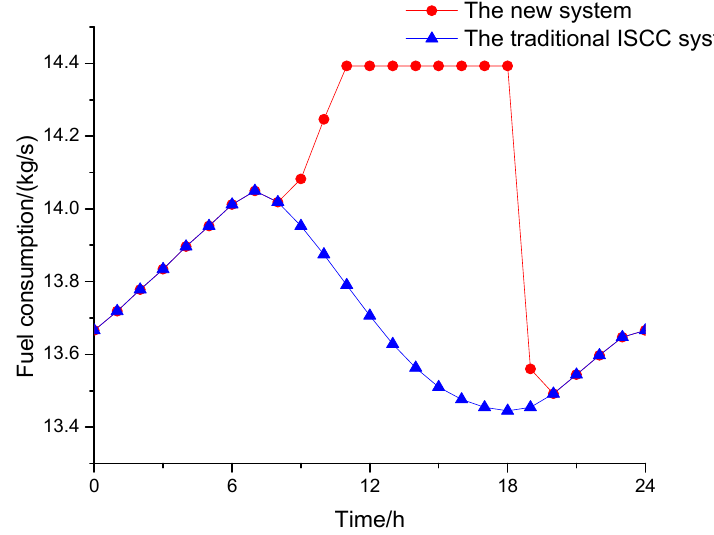
Figure 9. Fuel consumption of the traditional ISCC and the new system in a typical summer day.